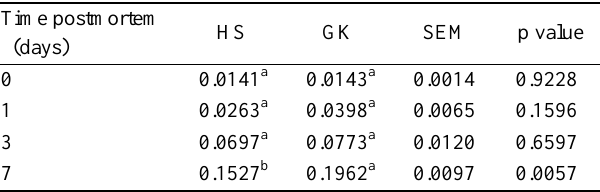
ab Least square means in the same row with different superscripts are significantly different at p<0.05 for the different types of slaughter at the same time postmortem. HS = Halal slaughter without stunning; GK = Gas stun-killing. SEM = Standard error of the means.